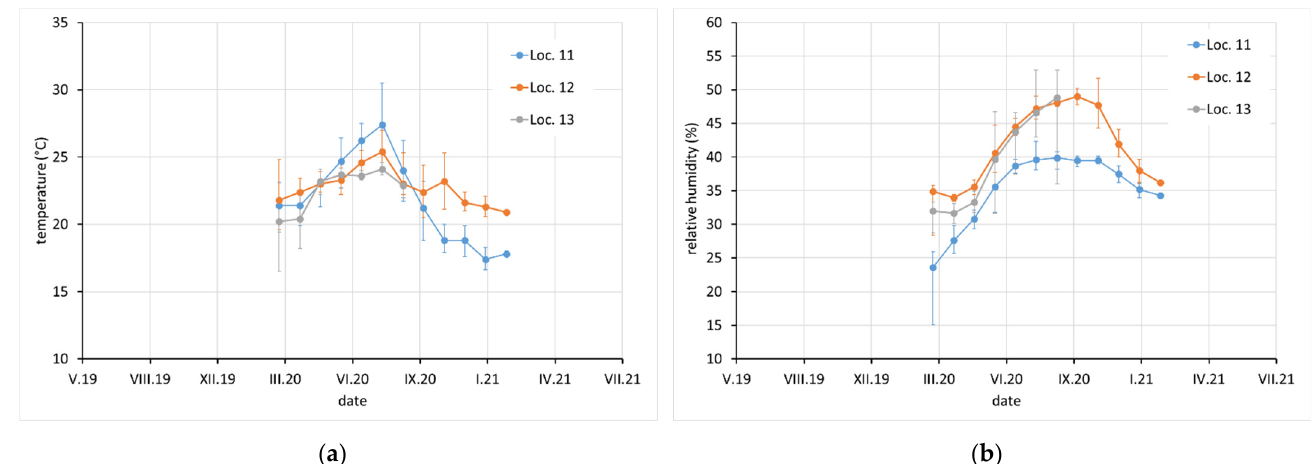
Figure 3. ( a ) Temperature and ( b ) relative humidity record at locations 5, 6, and 7. Points indicate average monthly values and error bars indicate monthly minimum and maximum.